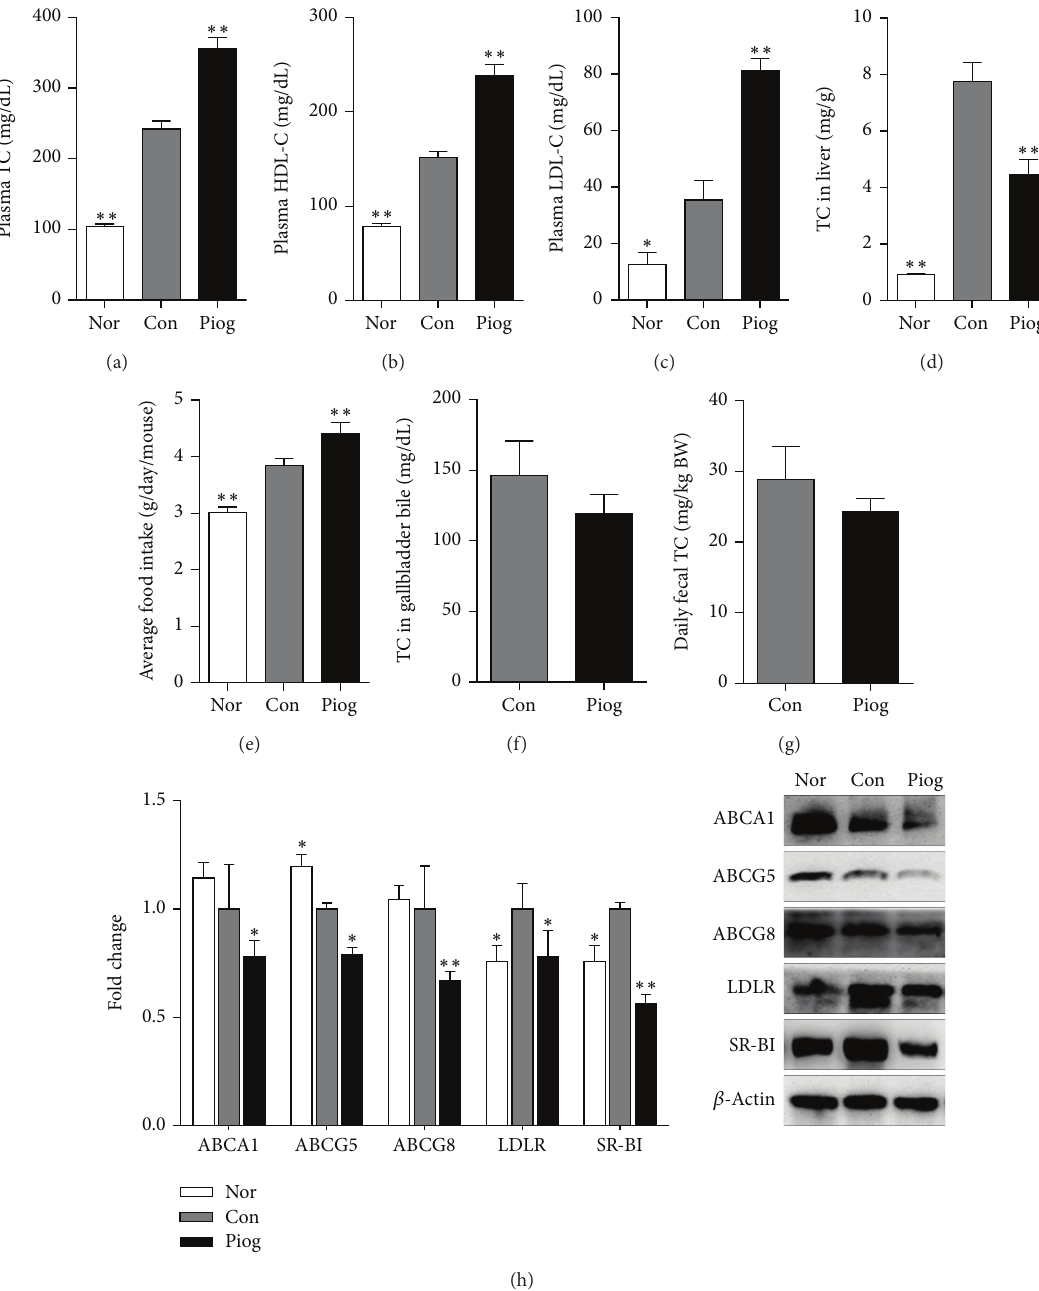
Figure 5: Effects of pioglitazone on cholesterol metabolism and associated hepatic protein expression in KKAy mice. The plasma TC (a), plasma HDL-C (a), plasma LDL-C (c), the levels of liver TC (d), the average food intake (e), gallbladder bile TC (f), and fecal TC (g) were measured as mentioned in Section 2. (h) Representative western blot for ABCA1, ABCG5, ABCG8, LDLR, SR-BI, and 𝛽 -actin is shown. The lower left bar graph represents statistical data from six individual mice per group. The bands were determined by densitometric analysis and expressed as fold change, after correction for 𝛽 -actin levels, relative to the control mice. Nor, C57BL/6J mice; Con, vehicle-treated KKAy mice; Piog, pioglitazone-treated KKAy mice. Data are presented as mean ± S.E.M. ( 𝑛 = 10 for biochemical analysis and 𝑛 = 6 for protein analysis). ∗ 𝑃 < 0.05 , ∗∗ 𝑃 < 0.01 versus